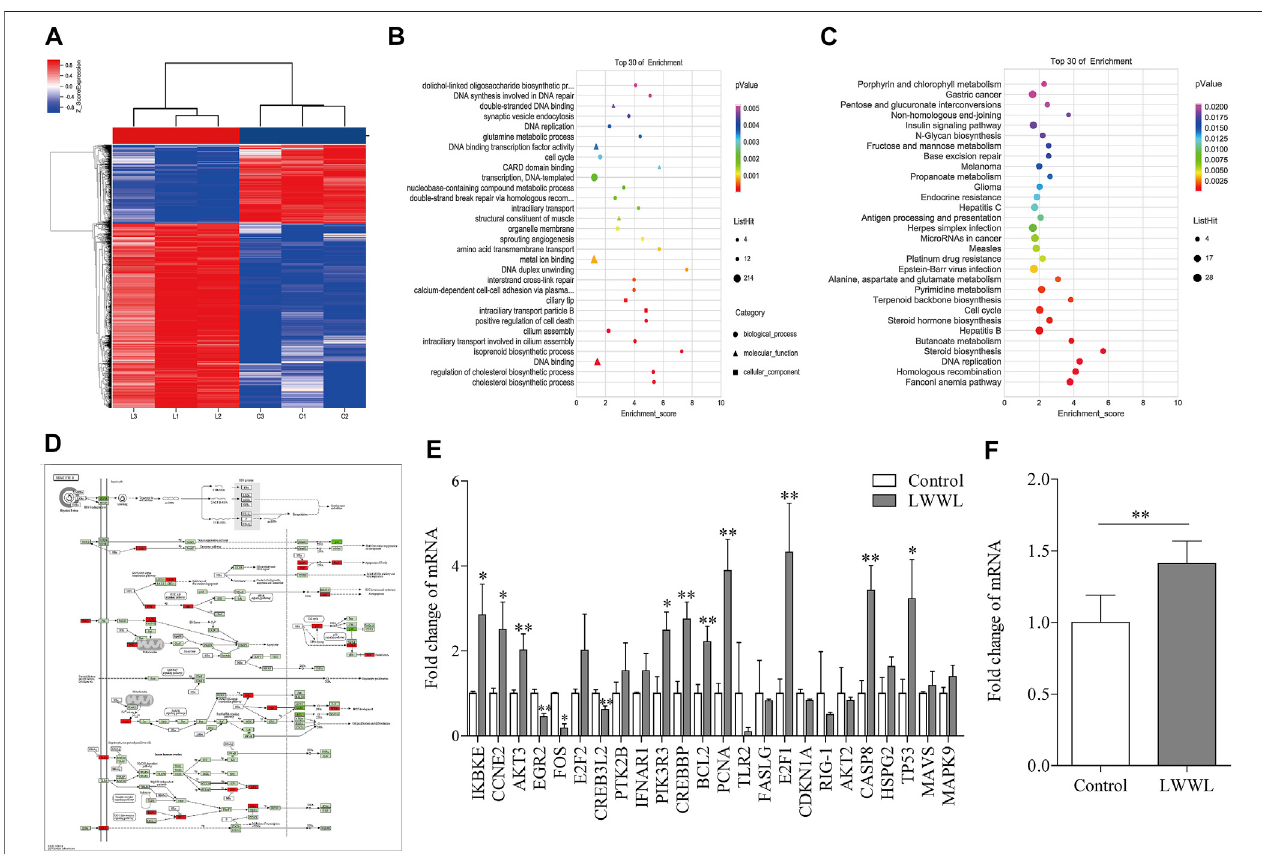
FIGURE 6 | Analysis of target and pathway of LWWL against HBV based on transcriptomics in HepG2.2.15 cells. (A) Heat map of DEGs compared LWWL and control. Red region indicates signi fi cantly up-regulated genes of LWWL compared to control, and blue region indicates signi fi cantly down- regulated genes of LWWL compared to control. (B) The GO analysis of DEGs. (C) The KEGG pathway analysis of DEGs. (D) DEGs involved in HBV infection pathway by KEGG pathway enrichment analysis. Red boxes indicate signi fi cantly up-regulated genes of LWWL compared to control, and green boxes indicate signi fi cantly down-regulated genes of LWWL compared to control. (E) Validation of DEGs in HBV-related pathway by KEGG pathway enrichment analysis. (F) Validation of end effector molecules IFN- β in IFN- β pathway in HBV-related pathway. * and ** represent p < 0.05 and p < 0.01 respectively in difference comparison between resultant values treated with each indicated concentration of LWWL and the value treated with zero concentration of LWWL (control). LWWL, Liuweiwuling Tablet; interferon- β , IFN- β ; DEGs, differentially-expressed genes; KEGG, Kyoto Encyclopedia of Genes and Genomes database; GO, gene